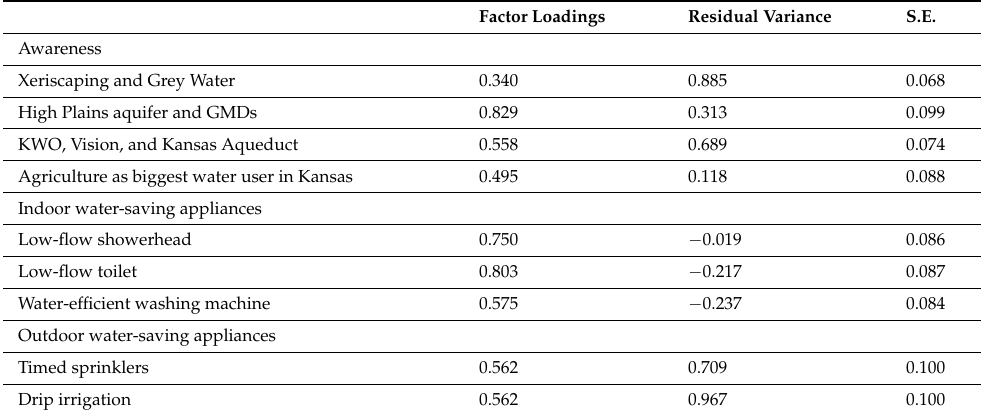
Table A4. Standardized model results of owning water-saving appliances for appliances for in- door and outdoor usage regressed on awareness levels for well owners without municipal utility connections (n = 141).